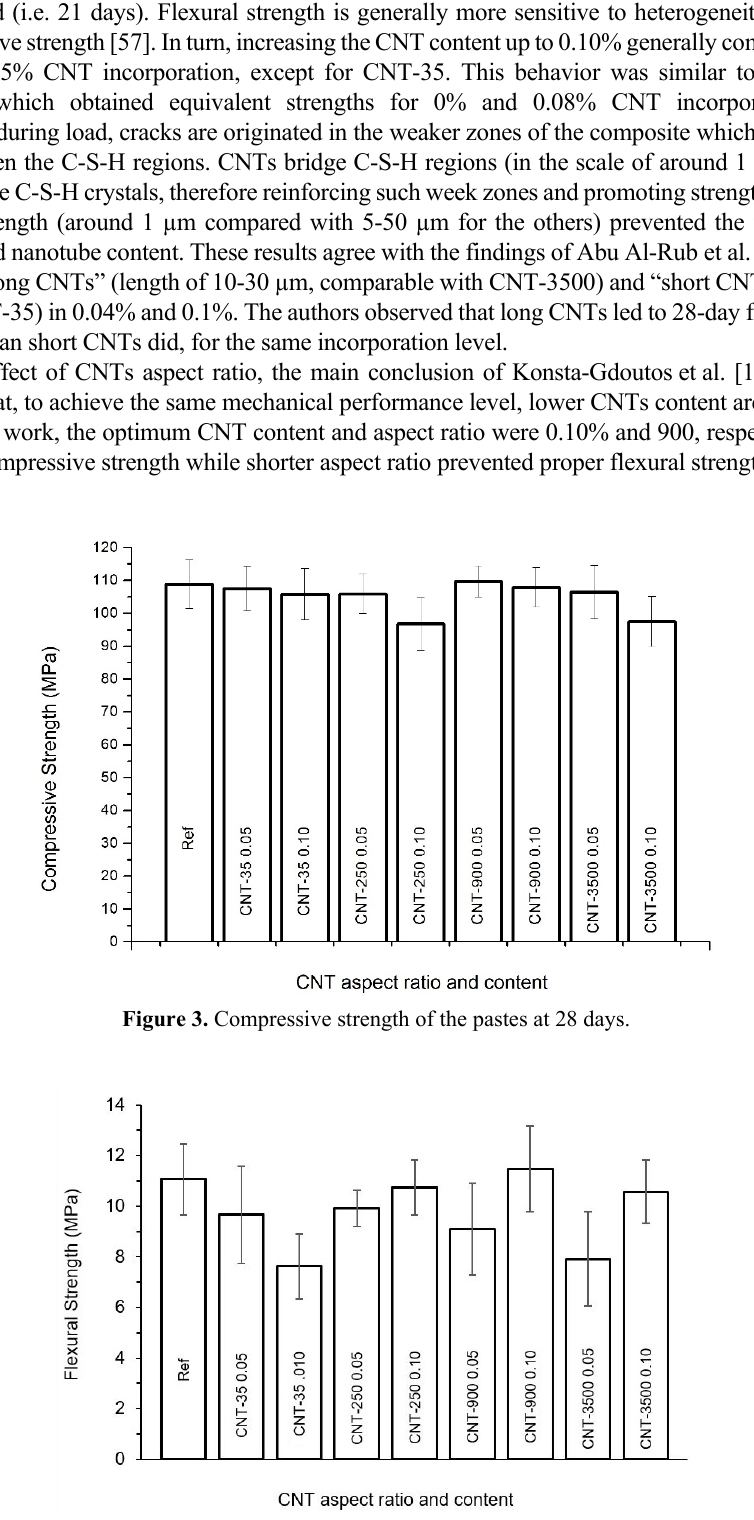
Figure 4. Flexural strength of the pastes at 28